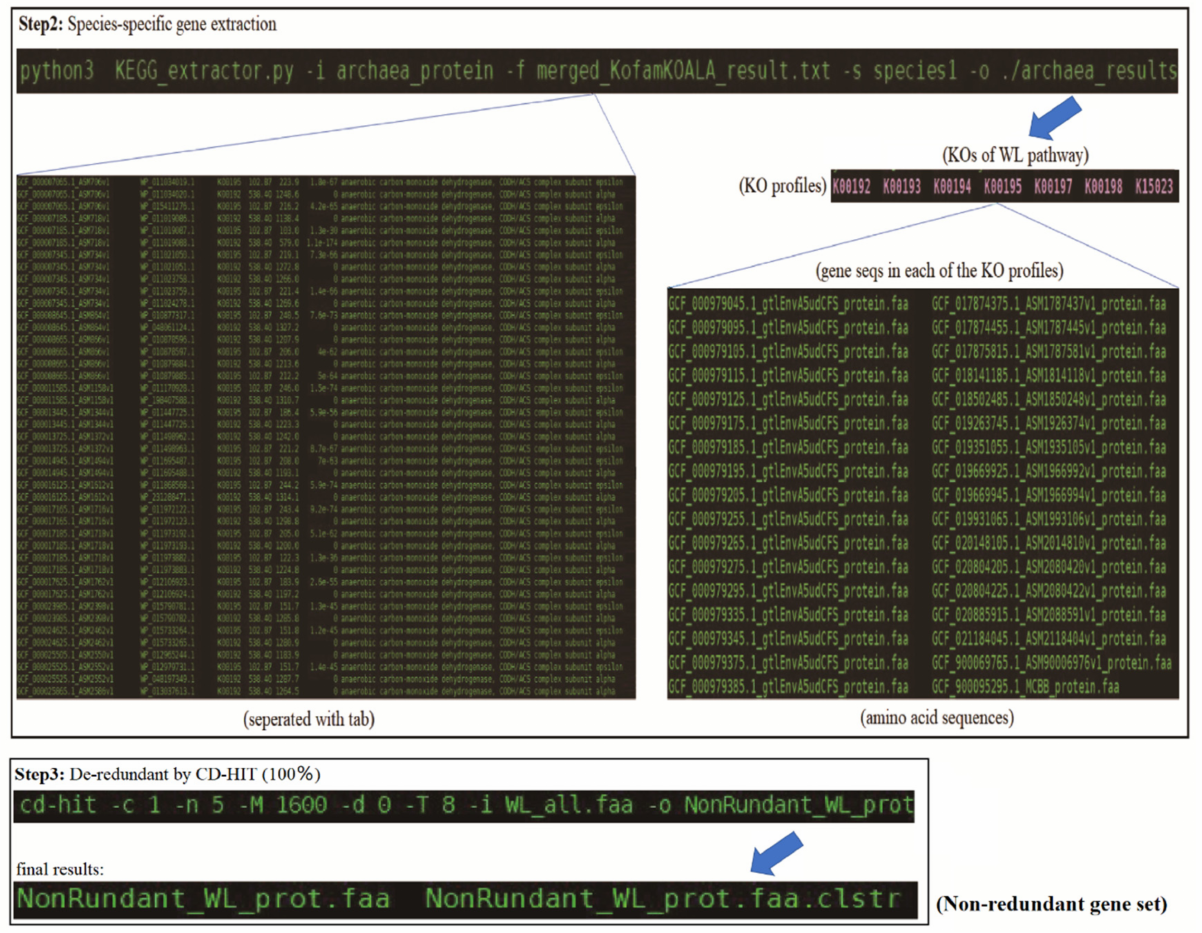
Figure 3. Step 2 and step 3 of the usage and applications: species-level gene extraction and de- redundancy through CD-HIT